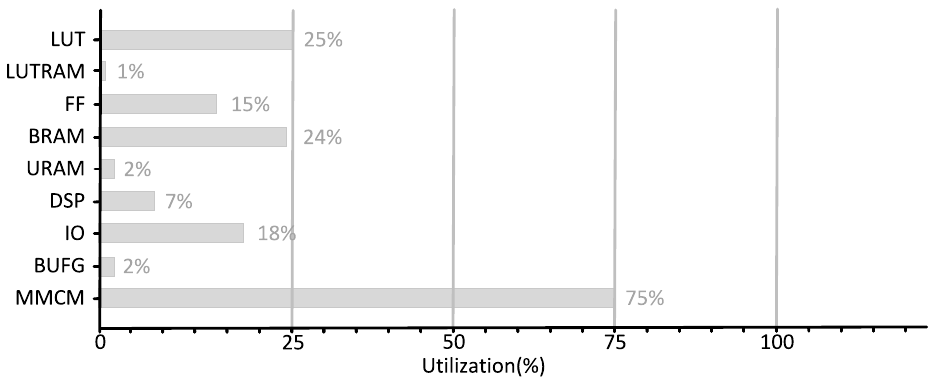
Figure 17. Overall resource consumption of the hardware platform.